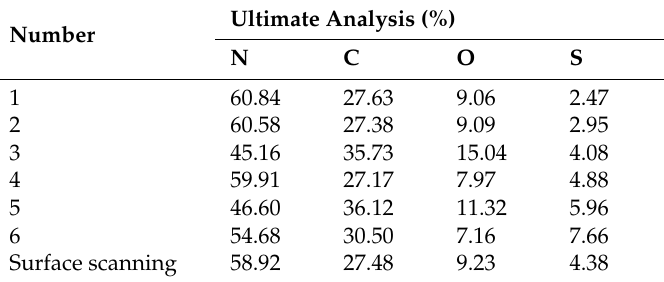
Figure 11. Scanning electron microscopy (SEM), images of TSC-CC resin ( a , b ); TSC-CC resin loaded Ag + ( c , d ). Table 4. Ultimate analysis of TSC-CC resin from energy dispersive spectrometer (EDS).